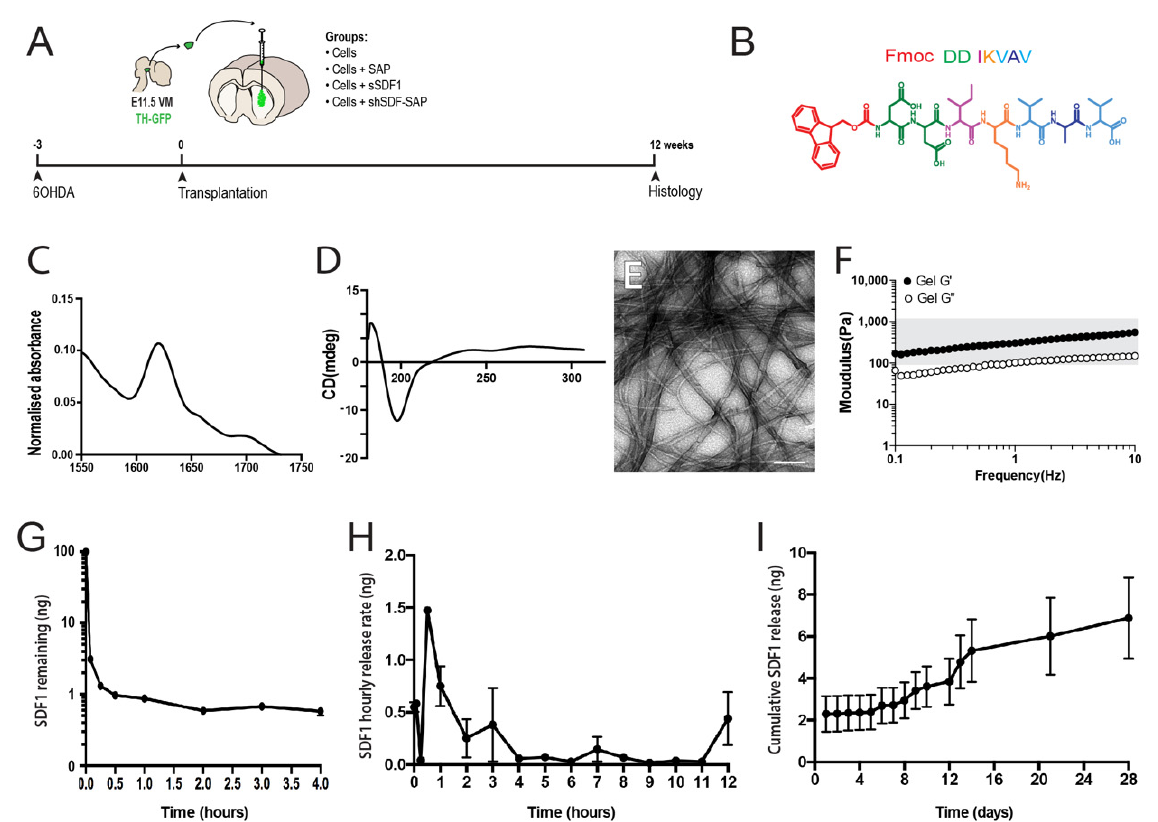
Figure 1. Generation and characterization of SDF1-functionalised hydrogel. ( A ) Schematic of in vivo experimental design highlighting the time frame of 6OHDA lesioning, neural progenitor/biomaterial implantation and histological assessment. ( B ) Illustration of the Fmoc-based peptide sequences, IKVAV. ( C ) Peptide interaction, through hydrogen bonds and secondary β sheet formation was confirmed by Fourier transform infrared (FTIR) of amide I region, showing characteristic peak for β sheets with an observable carbamate peak. ( D ) The stable formation of a dominant assembly, showing transition peaks at 200 nm, was confirmed by circular dichroism spectroscopy. ( E ) Representative electron micrograph illustrating the nanofibril structural organisation. ( F ) Storage (G ′ , black circles) and loss (G ″ , white circles) modulus for the IKVAV SAP hydrogel, showing similar stiffness to the rodent brain (indicated by grey shading). ( G ) Soluble SDF1 recombinant protein in media rapidly degraded (>90% degradation within minutes). ( H , I ) Shear entrapment of SDF1 in the SAP hydrogel resulted in sustained release, observed over 28 days. Scale bar: 100 nm.